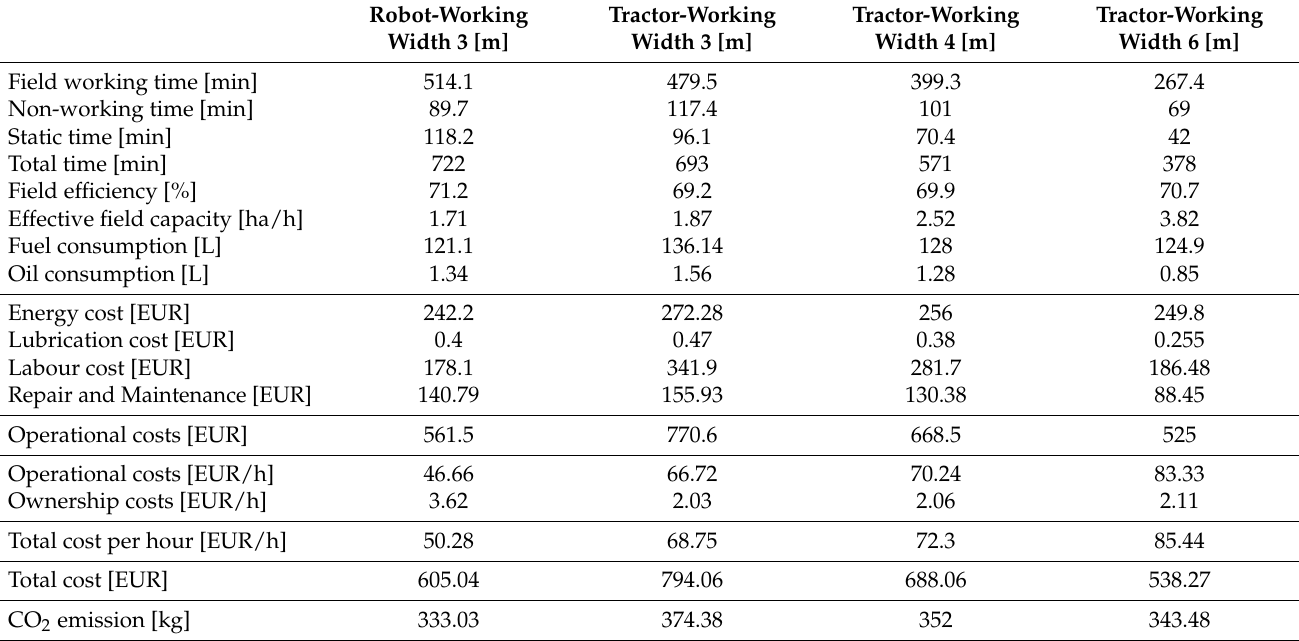
Figure 17. The sample field in the third scenario with a size equal to 21 ha. Table 10 represents the result of in-field operation for the robot and the tractor with different sizes of implementation. Table 10. The results of in-field operation for the third scenario for the robot and the tractor with different working